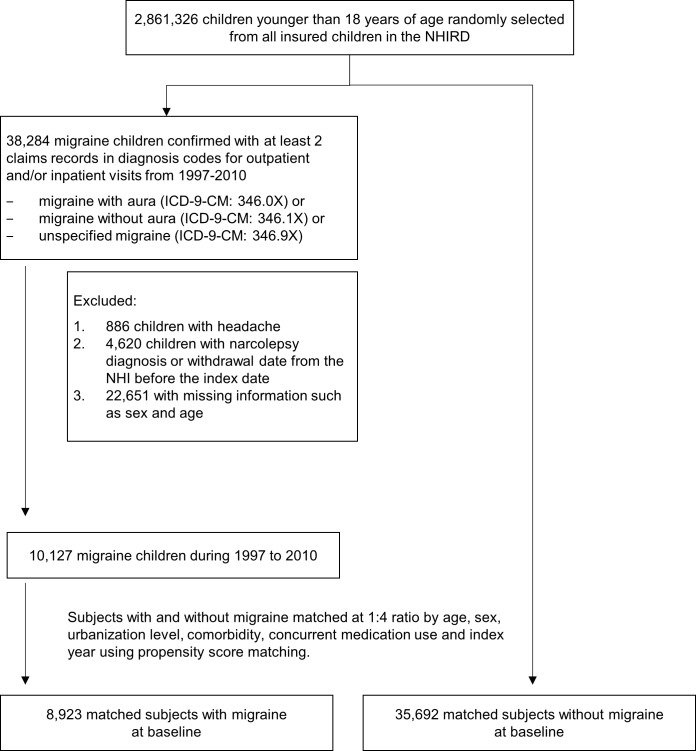
Subject selection flowchart.